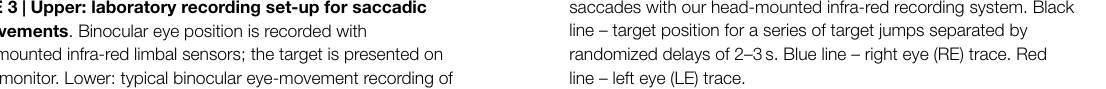
As shown in Figure 4 (upper), disparity vergence movements were recorded for a 32° random-dot field with a central fixation target presented on an alternate-line polarizing LCD monitor